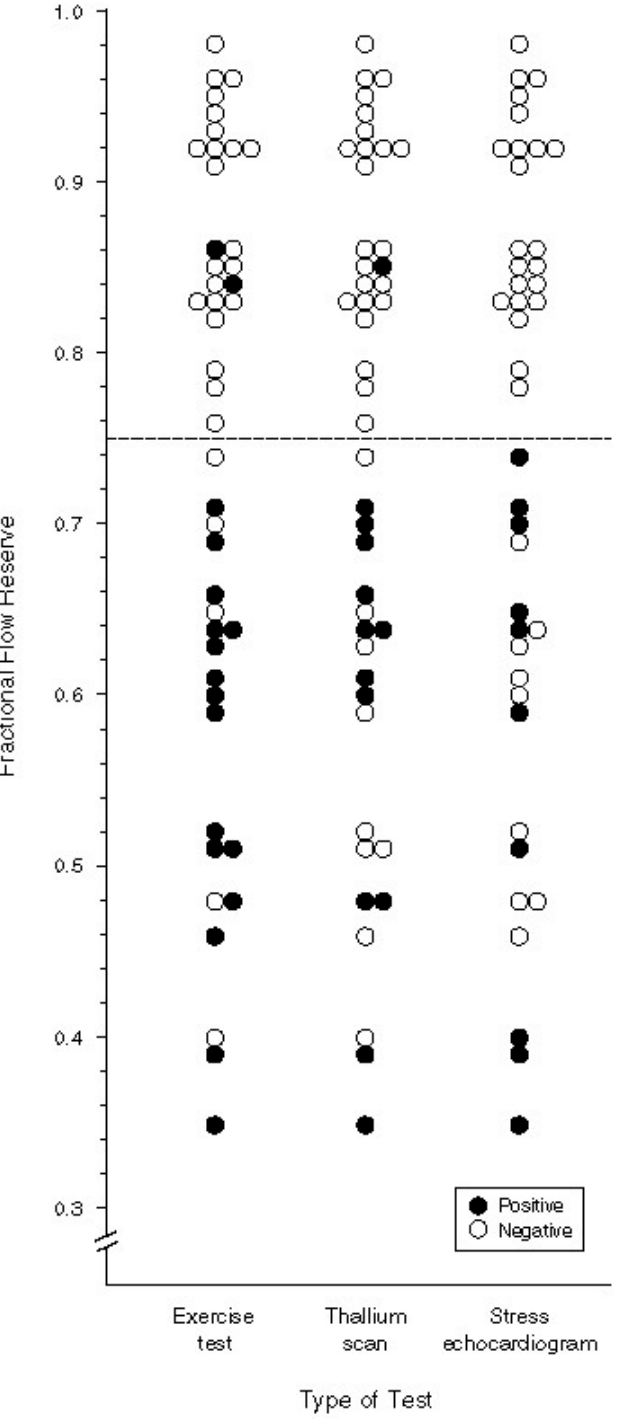
Figure 3. Non-invasive assessment of ischemia compared with FFR. Reprinted with permission from Pijls et al. [22]. In 45 patients with chest pain and moderate (~50%) coronary artery stenosis, exercise stress testing, thallium scintigraphy, and stress echocardiography with dobutamine were performed. These results were compared with FFR measurements. The dashed line indicates the pre-specified FFR threshold for ischemia of 0.75 and each circle represents patients who were found to have ischemia or no ischemia by stress testing. Nearly every patient with ischemia by stress testing was found to have a coronary stenosis with an ischemic FFR value. After revascularization non-invasive tests were repeated and there was no longer evidence of ischemia.